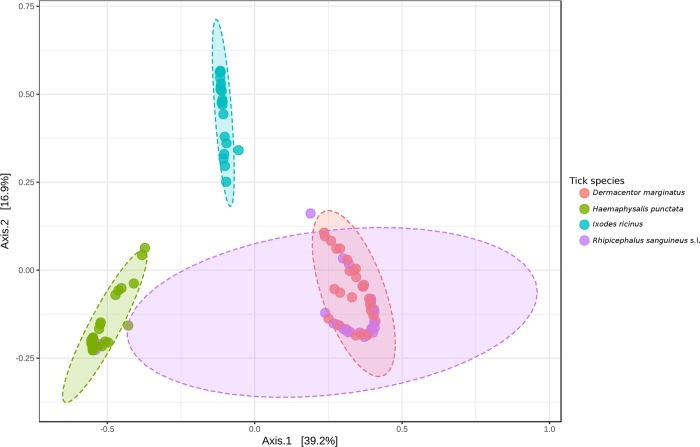
Principal Component Analysis (PCoA) generated among groups at genus level using Weighted UniFrac metric (a measure of differences in bacterial community structure).